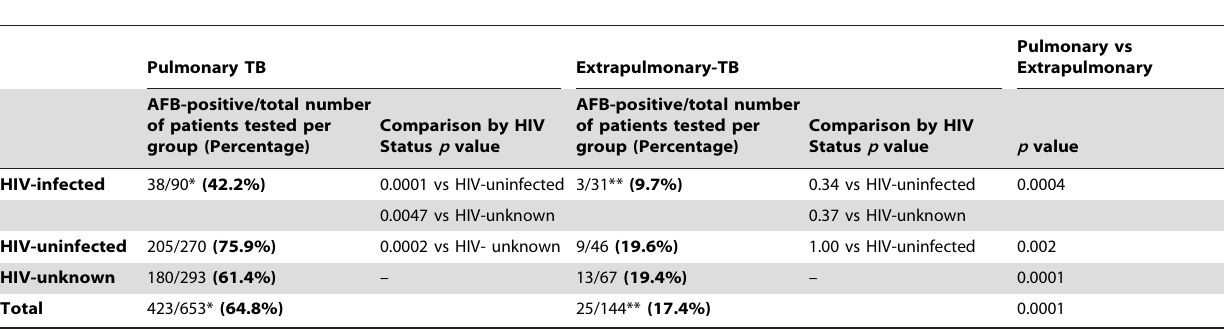
Table 5. Frequency of smear microscopy positive results of patients with active-TB according to their disease localization and HIV- status.